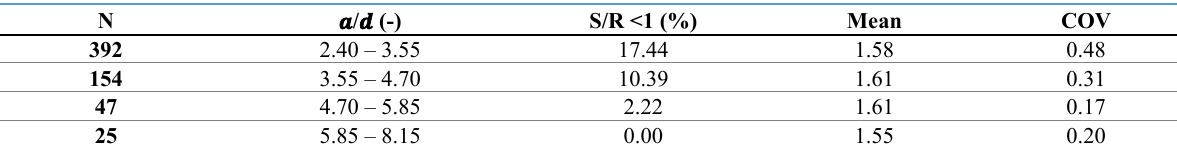
Table 13 - S/R x a/d to NBR 6118: